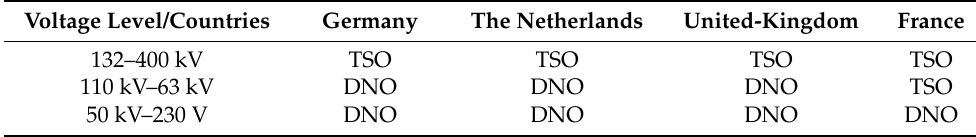
Table 1. Perimeter of network operators in Europe. Voltage